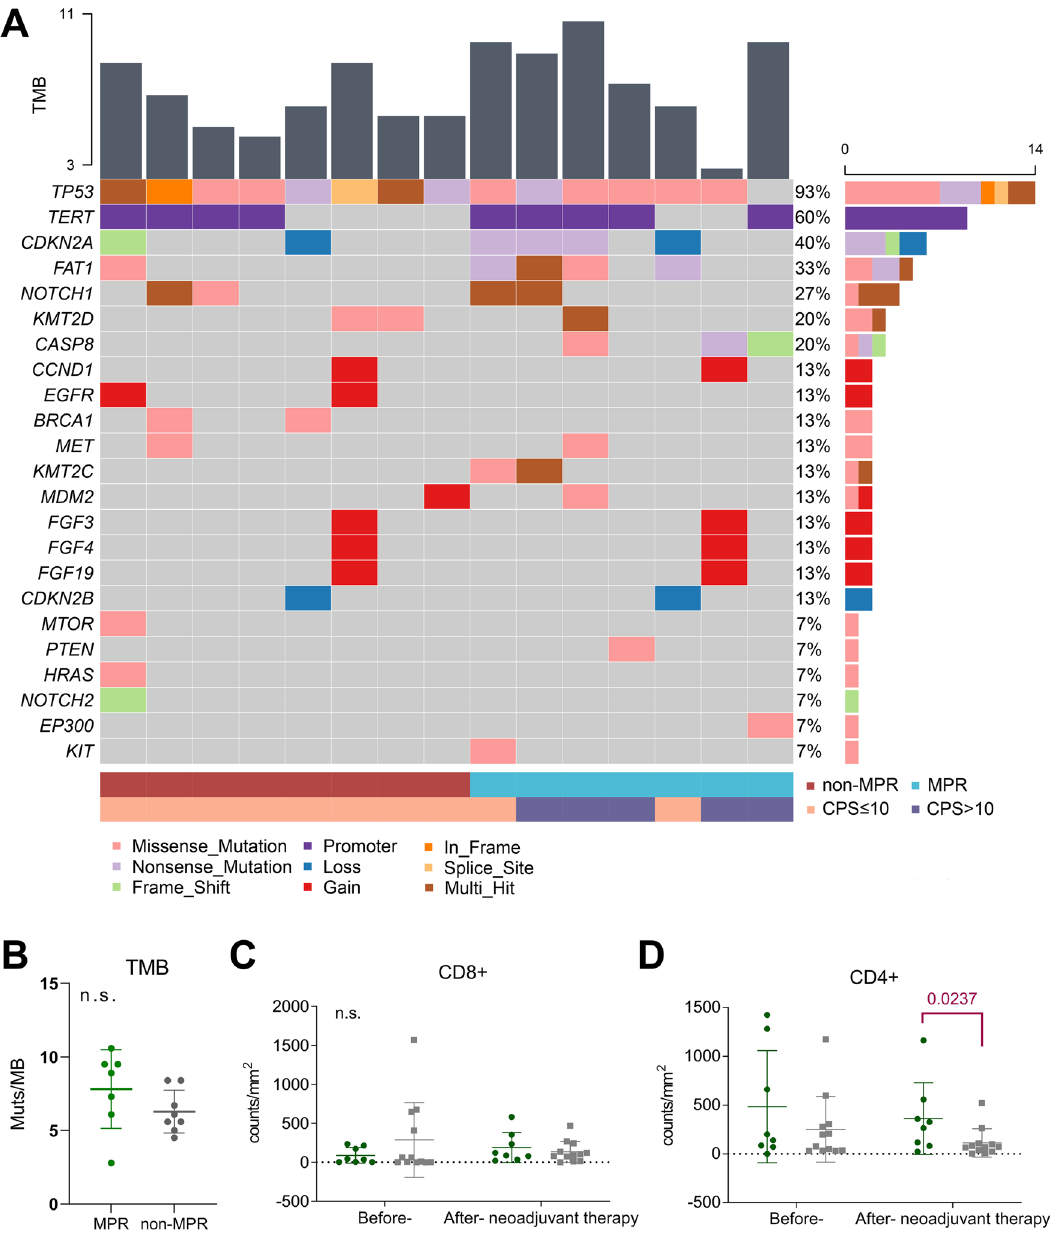
Fig. 3 | Genetic and tumour-in fi ltrating lymphocyte analyses. A Mutations as assessed by next-generation sequencing of baseline primary tumour samples. A column represents a patient. The percentages listed on the right represent the proportionofsamplesharbouringamutationinthegenelistedontheleft.Bottom bars show pathological response (MPR [ n =8] or non-MPR [ n =7]) and combined positive score ( ˃ 10 [ n =5] or ≤ 10 [ n =10]) distribution. B Comparison of TMB in baseline tumour samples between the MPR and non-MPR groups (green dots for the MPR group [ n =7], grey dots for the non-MPR group [ n =8]). Quantitative